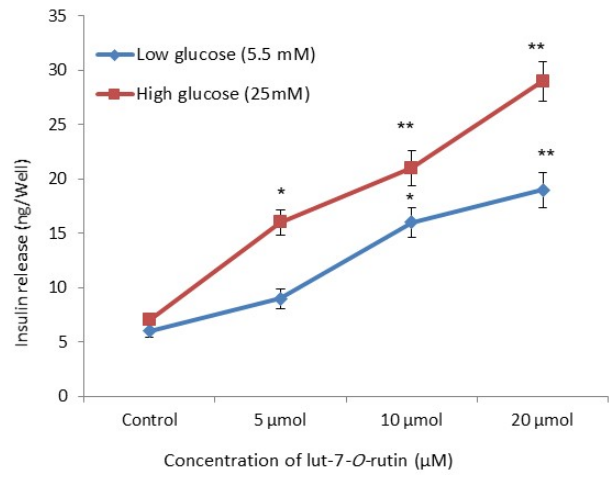
Figure 3. Effect of lut-7 -O- rutinoside on glucose-stimulated insulin secretion in RIN-5F cells. Each value is presented as the mean ± SD for 6 replicates. *: p ≤ 0.05 and **: p ≤ 0.001, lut-7 -O- rutinoside- treated groups compared with the control and the low-glucose medium.